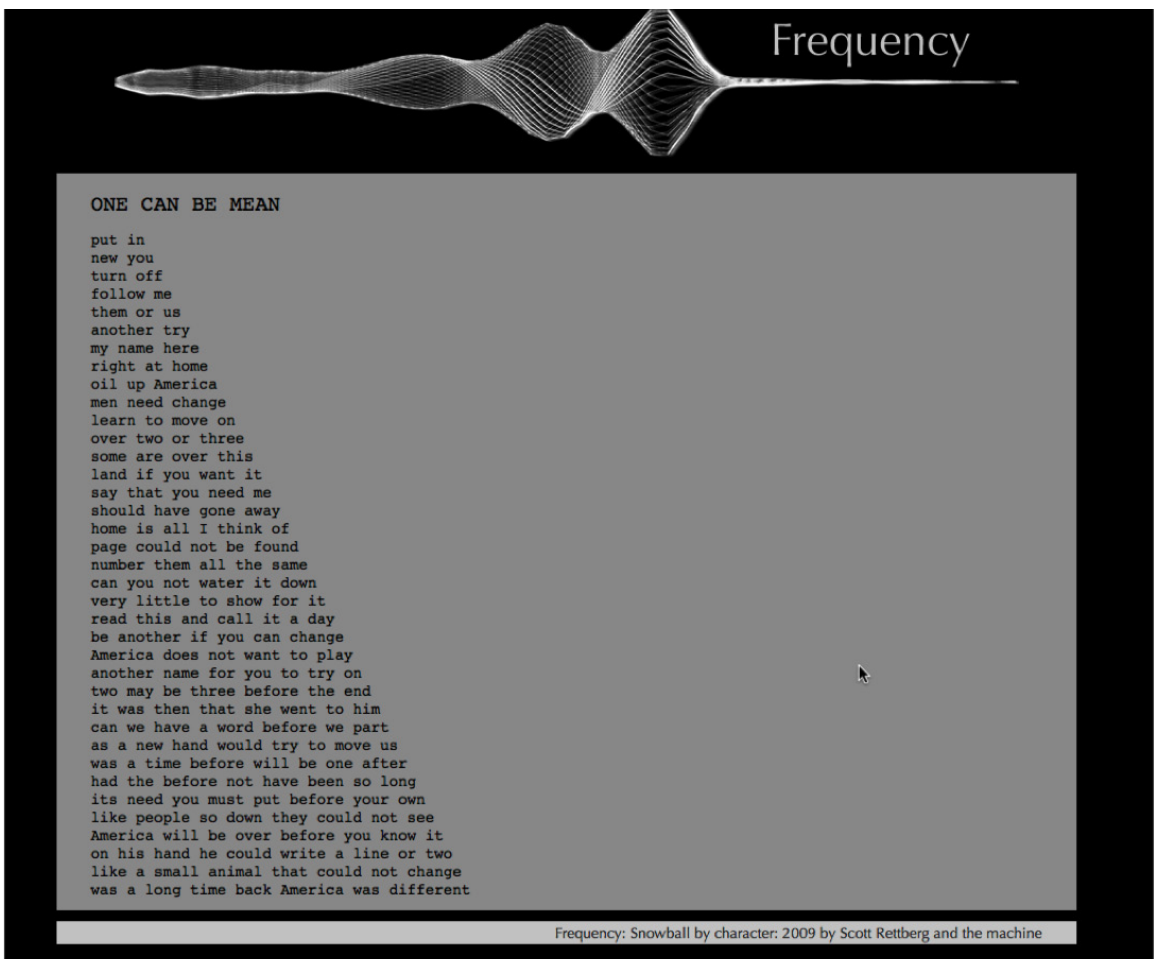
FIGURE 6 | Scott Rettberg, Frequency Poems (2009). Online, open-source artwork (Detail: “One Can Be Mean”. Fre- quency: Snowball by character). Code, computer and screen display. Courtesy Scott